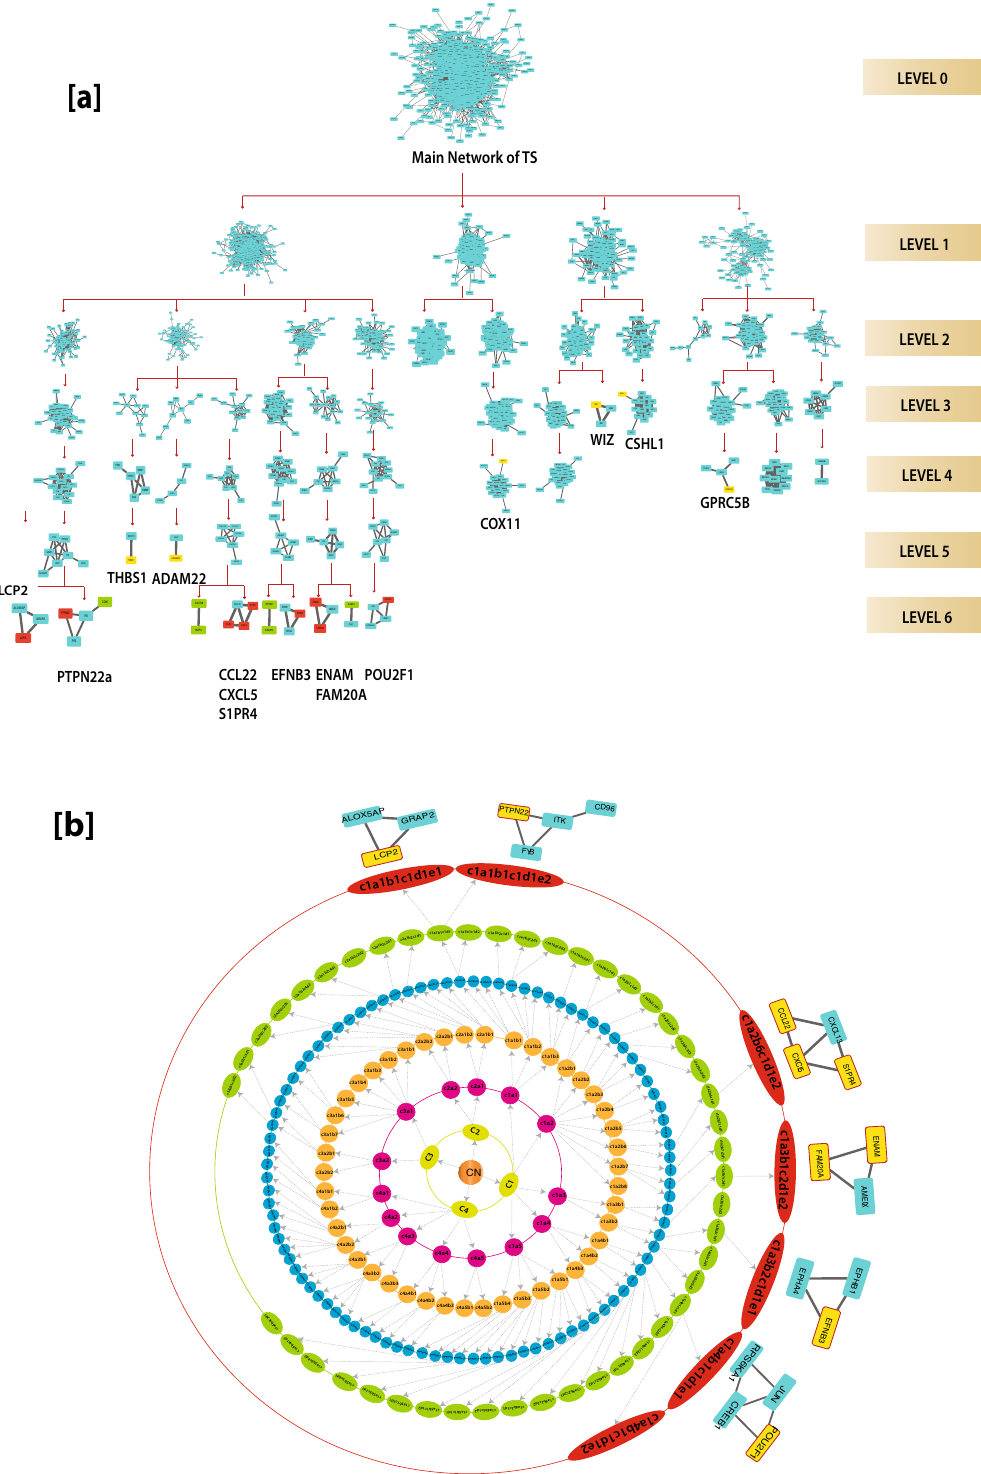
Figure 4. ( a ) Network/modules/sub-modules at different levels which accommodate leading hubs and key regulators. ( b ) Organization of the modules/sub-modules of the TS